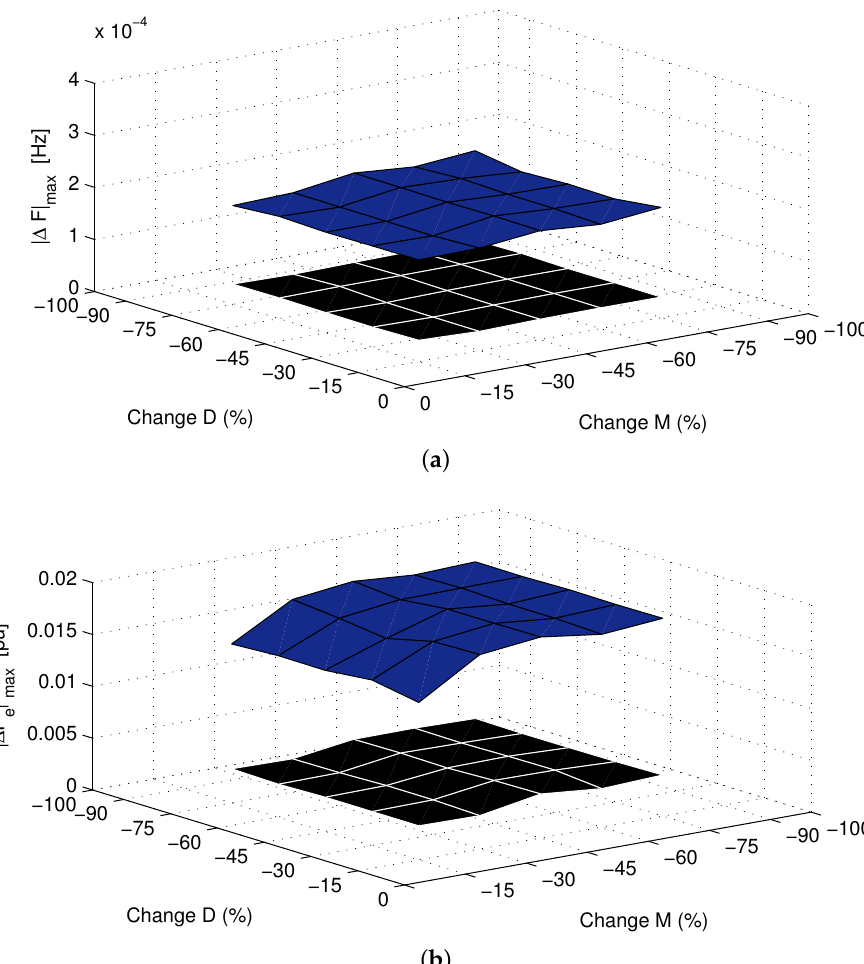
Figure 18. ( a ) | ∆ F | max for system parameters variation: PF (black), FLC (blue); ( b ) | ∆ P e | max for system parameters variation: PF (black), FLC